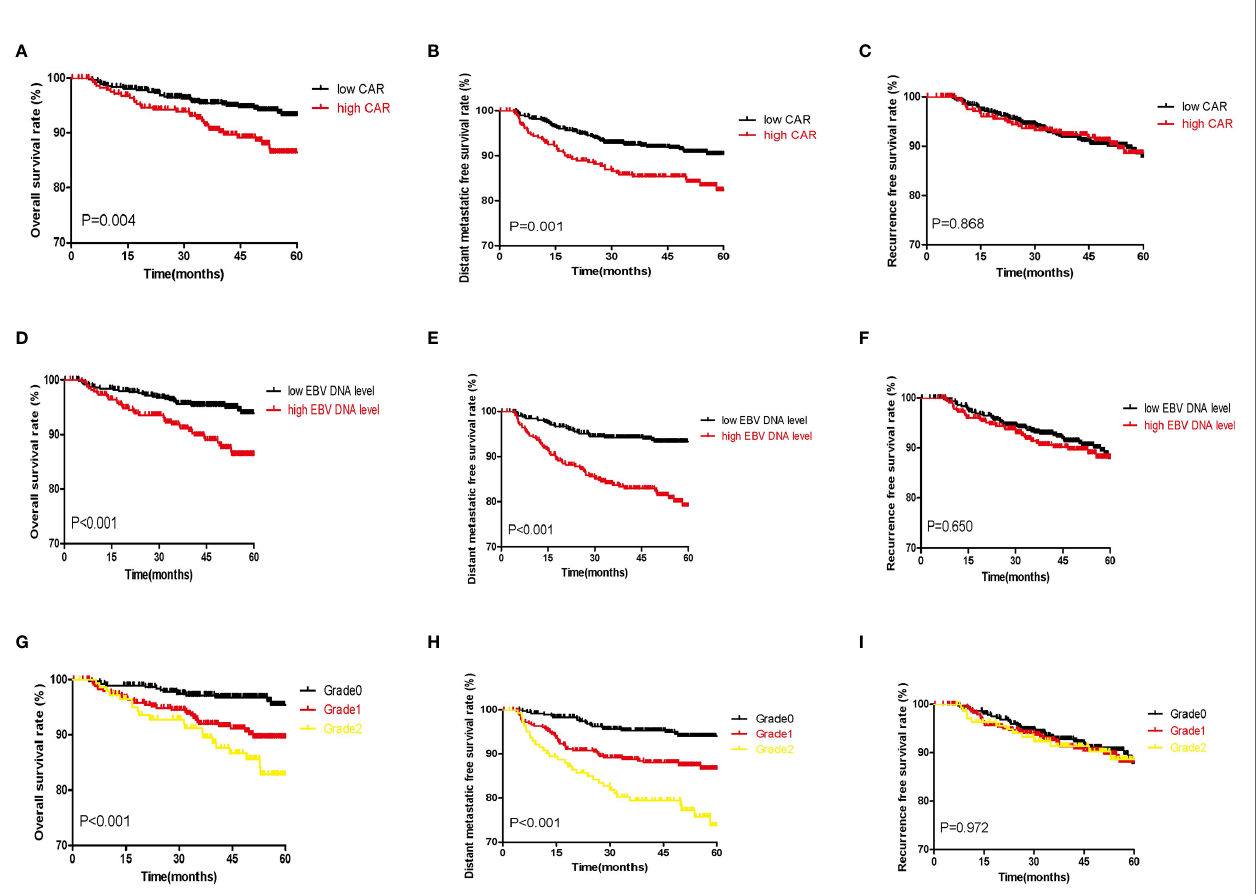
FIGURE 2 | Kaplan – Meier survival curves of the whole set of patients with NPC patients. (A – C) show the survival curves for OS, DMFS, and RFS, respectively, according to the classi fi cation of CAR. (D – F) show the survival curves for OS, DMFS, and RFS, respectively, according to classi fi cation of EBV DNA copy number. (G – I) show the survival curves for OS, DMFS, and RFS, respectively, according to classi fi cation of C-E